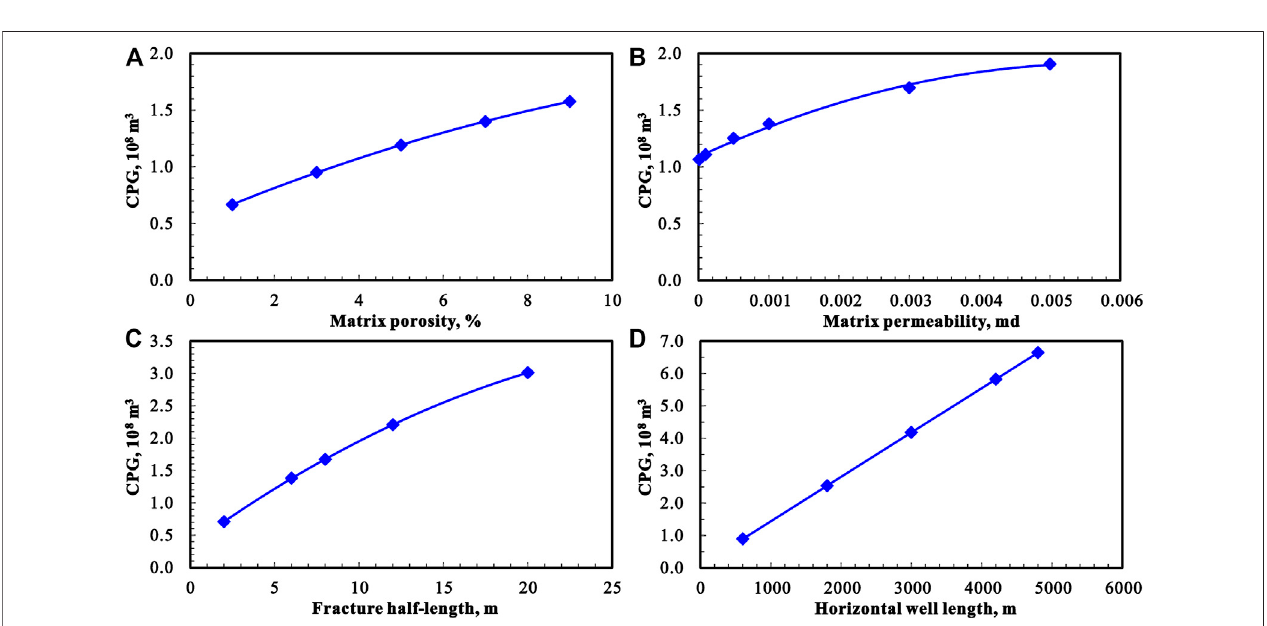
FIGURE 5 | (A) The relationship between matrix porosity and CGP (Cumulative gas production of 15 years). (B) The relationship between matrix permeability and CGP. (C) The relationship between fracture half-length and CGP. (D) The relationship between horizontal well length and CGP.